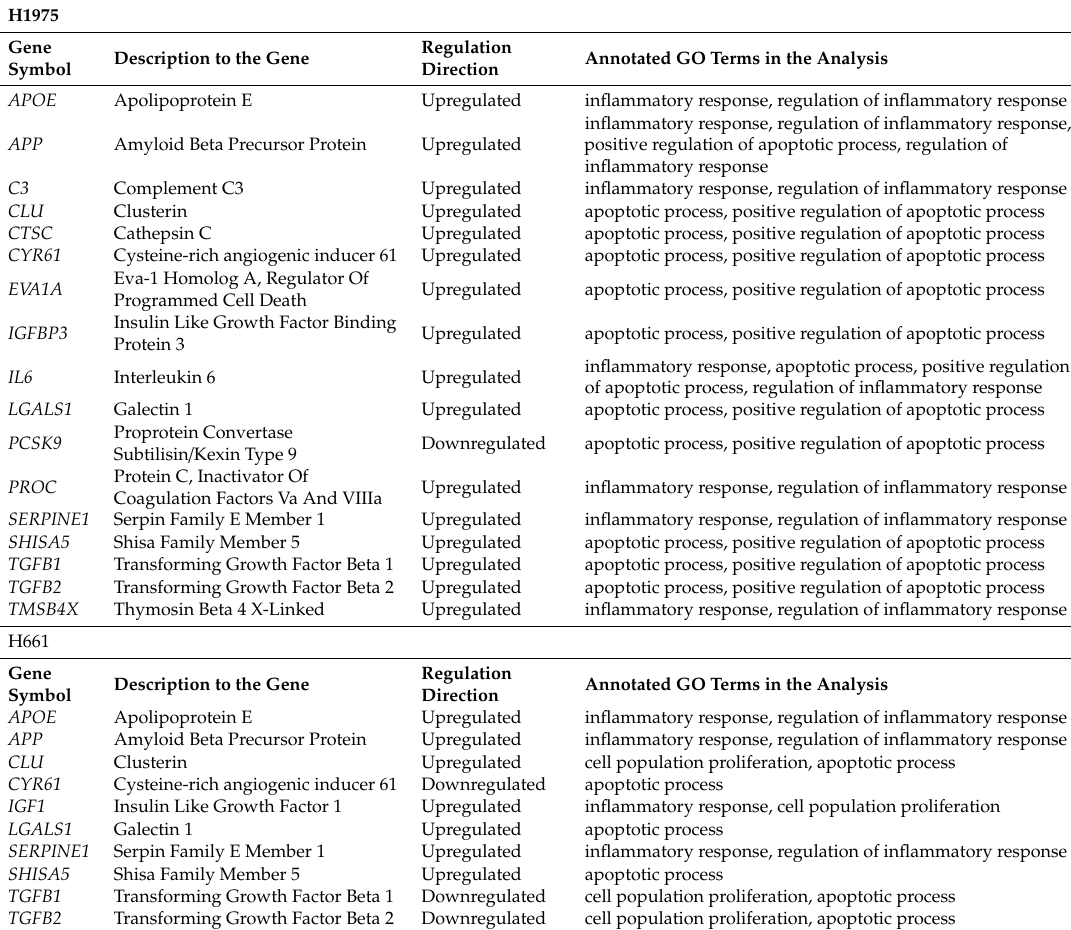
Table 3. S ERPINA1 -related Di ff erentially Expressed Genes in H1975 and H661